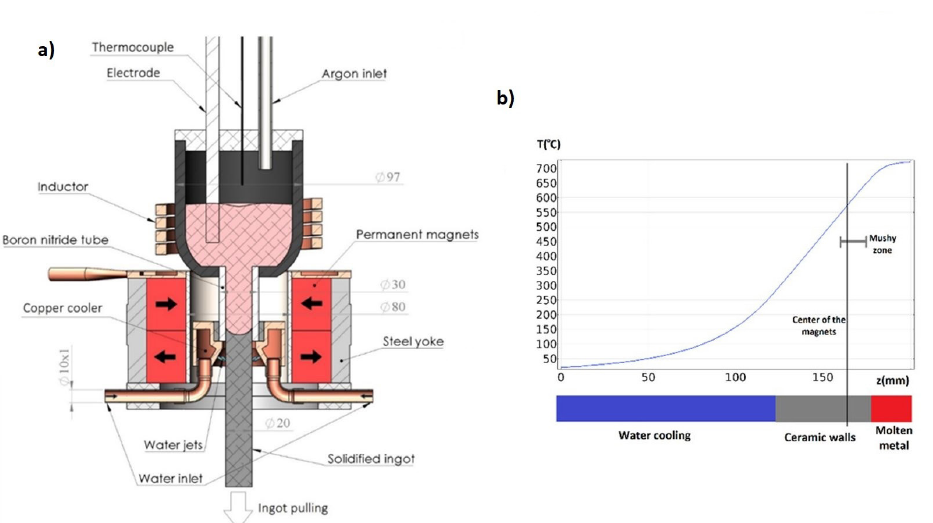
Figure 1. Directional solidification experiment: a) Cross section of the experimental setup; b) Temperature distribution along the symmetry